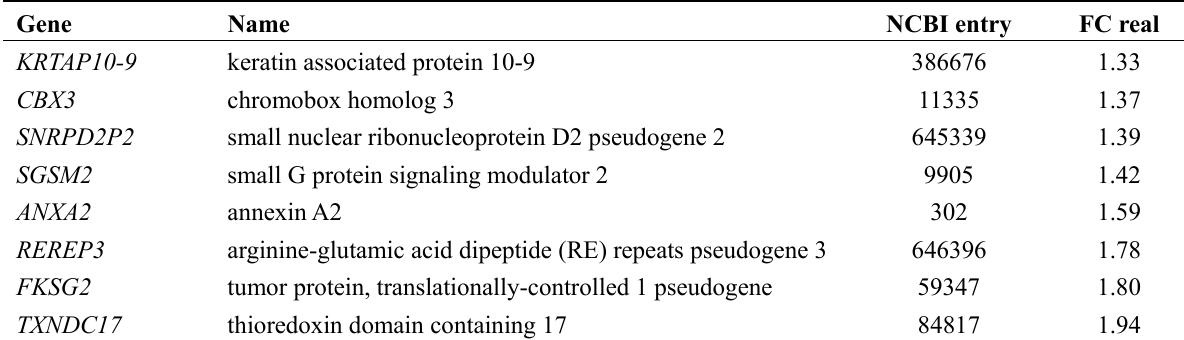
Figure 5. Effects of paraoxon and mipafox on the neural differentiation. During the initial process of neural differentiation NT2 cells were seeded on 96-well plates and exposed to 1 µM paraoxon or 5 µM mipafox for 13 days. Using the Cellomics ArrayScan device the following morphological parameters of the cells positively stained against β -Tubulin III were quantified: differentiating neuronal-like cells (cells with more than 3 neurites or with a neurite total length longer than 6.5 µm) ( A ); number of branch points ( B ) and length